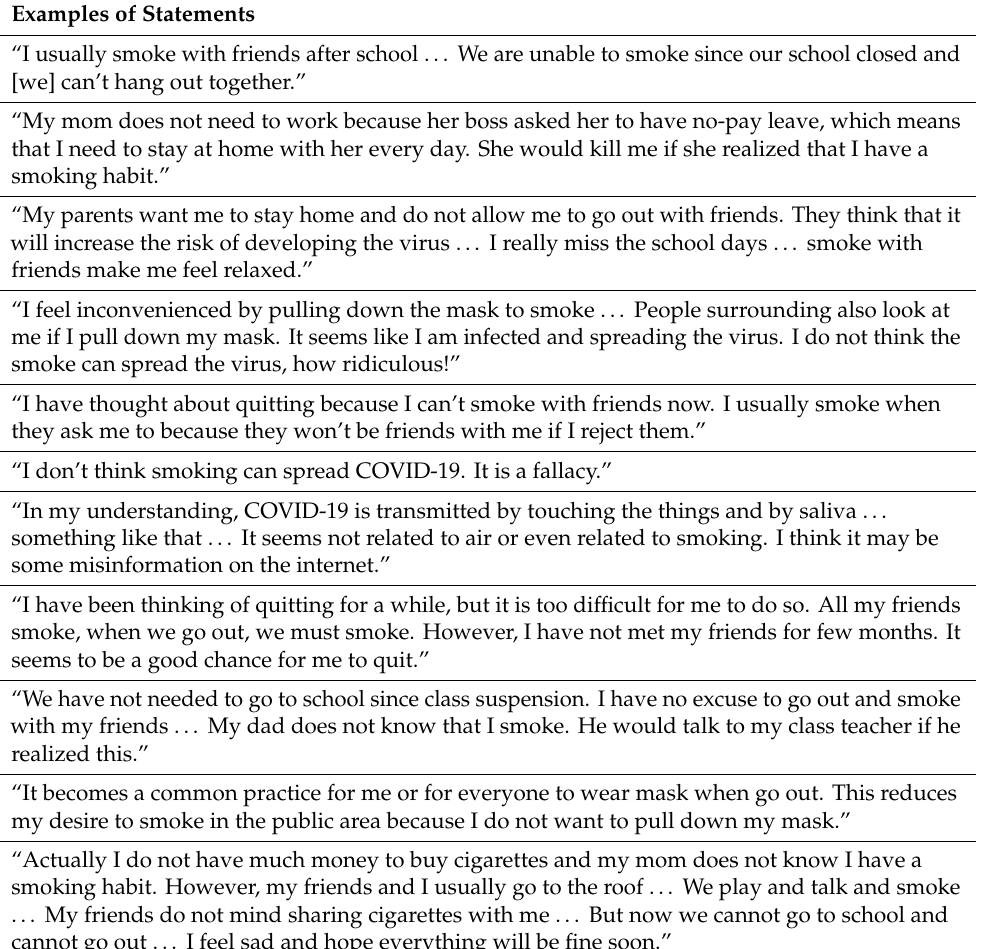
Table 2. A summary of